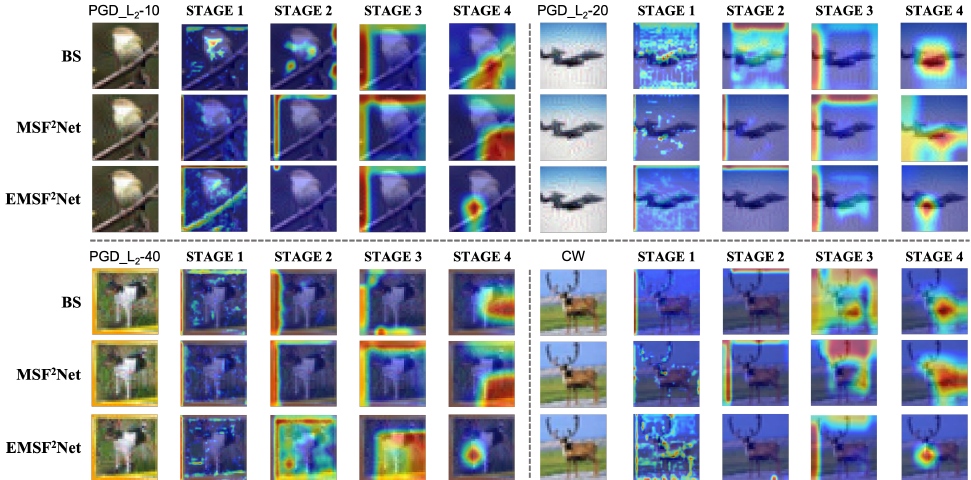
Figure 7. Grad-cam visualization results of the baseline, MSF 2 Net, and EMSF 2 Net under adversarial attacks with L 2 -norm.